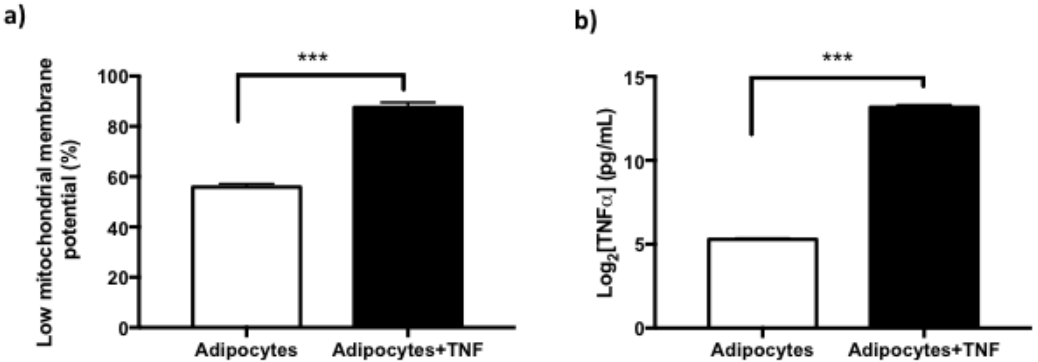
Figure 5. Secretory Senescence-Associated Phenotype (SASP) in adipocytes treated with TNF α . ( a ) Increase of newly differentiated adipocytes with low mitochondrial membrane potential by TNF α (125 ng/mL, 24 h) treatment, three independent experiments were carried out. Student t test *** p < 0.001 ( b ) Basal TNF α secretion levels in newly differentiated adipocytes and increase TNF α -secretion in adipocytes after TNF α treatment, three independent experiments were carried out. Student’s t test *** p < 0.001.